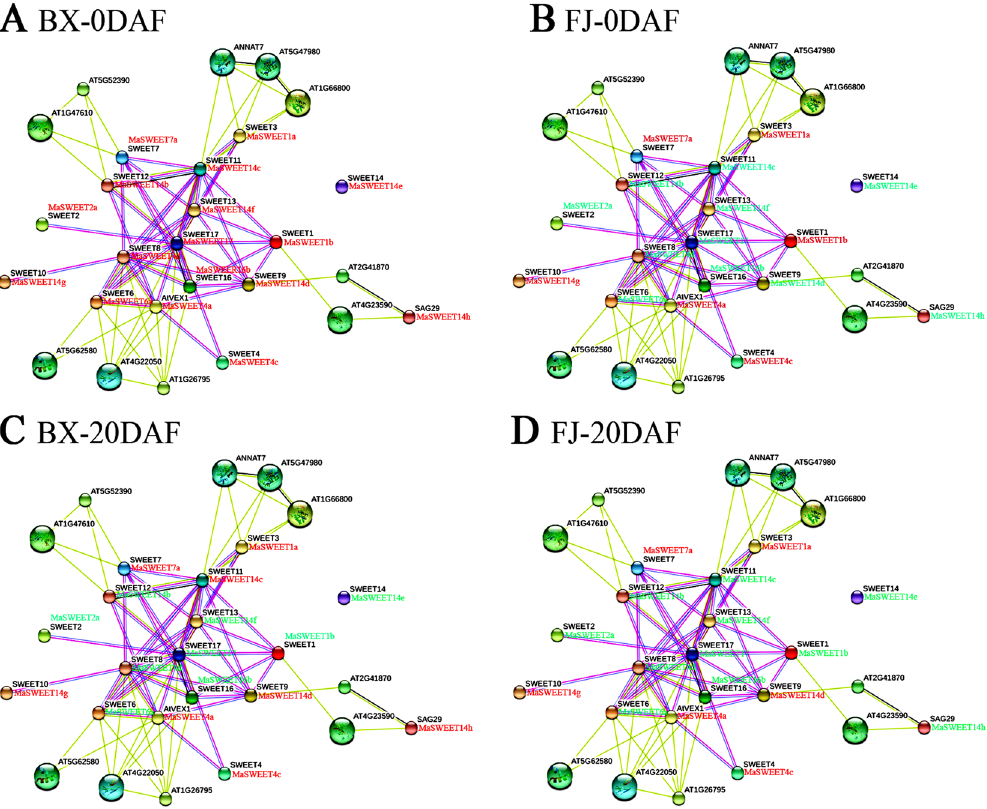
Figure 9. Interaction network and co-expression analyses of MaSWEETs at 0 DAF ( A , B ) and 20 DAF ( C , D ) in BX and FJ banana varieties and related genes in Arabidopsis . Line thickness relates to combined score. Genes marked in red show upregulation in BX and FJ. Genes marked in green show downregulation in BX and